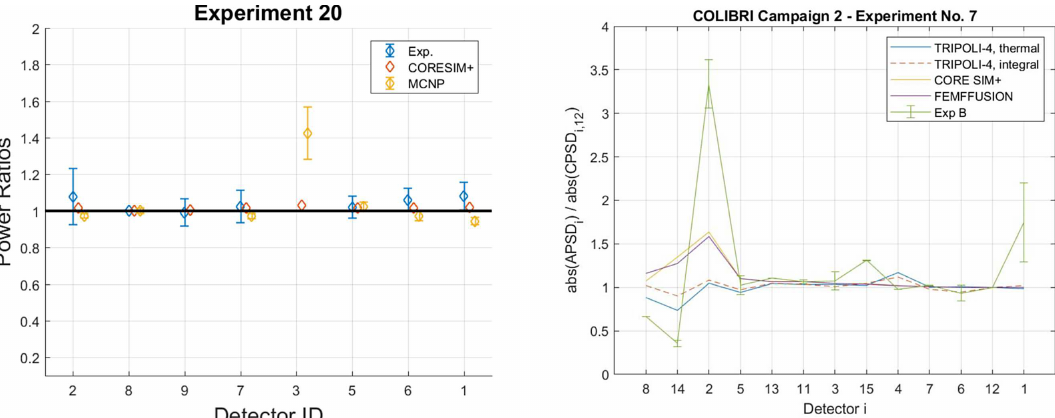
Fig. 4. Comparisons between the calculated and measured neutron noise (given with uncertainties) of the 2nd campaign at AKR-2, experiment #20 (left) and of the 2nd campaign at CROCUS, experiment #7 (right). The figures give the amplitude of the auto-power spectral density of the relative neutron noise (estimated in relation to a reference detector). Figure derived from